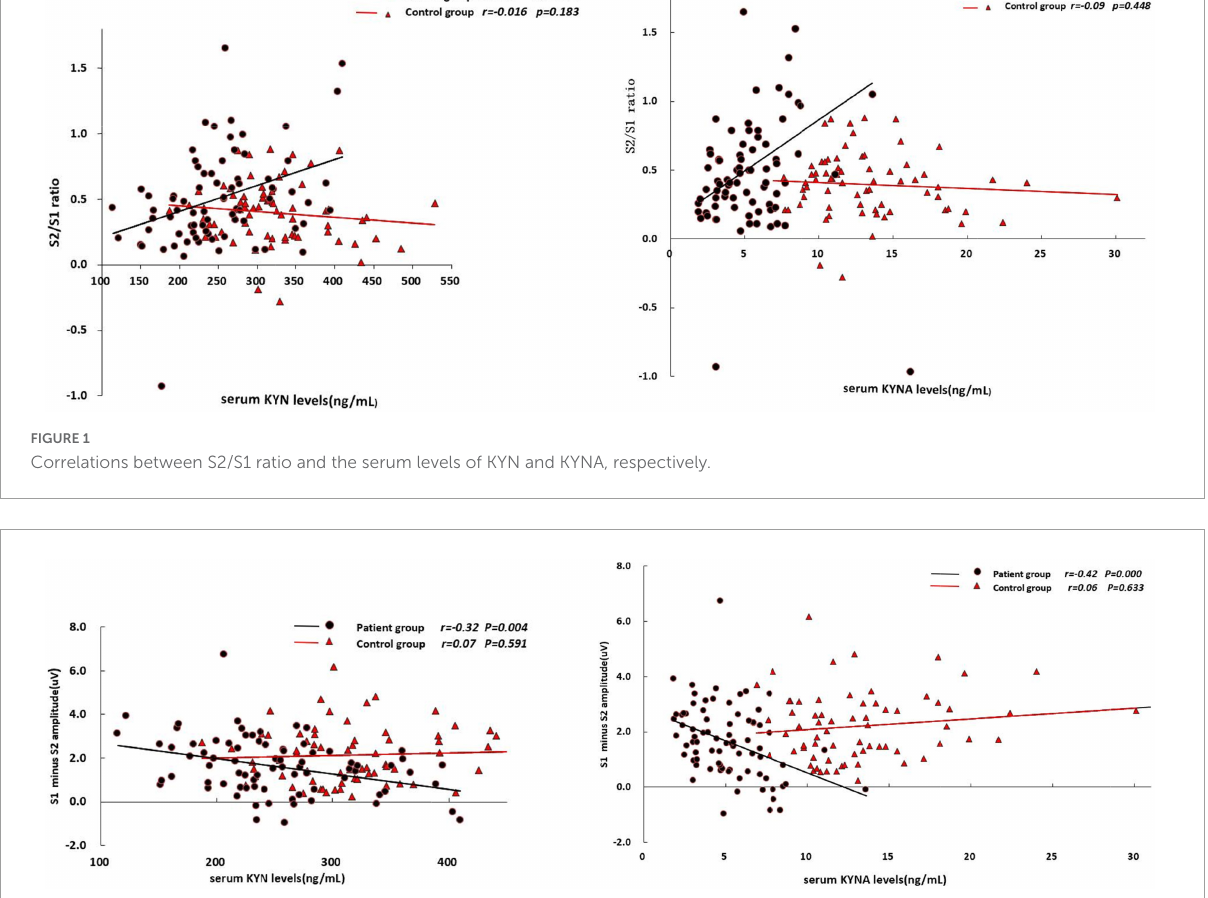
FIGURE2 Correlations between S1–S2 amplitude difference and the serum levels of KYN and KYNA,